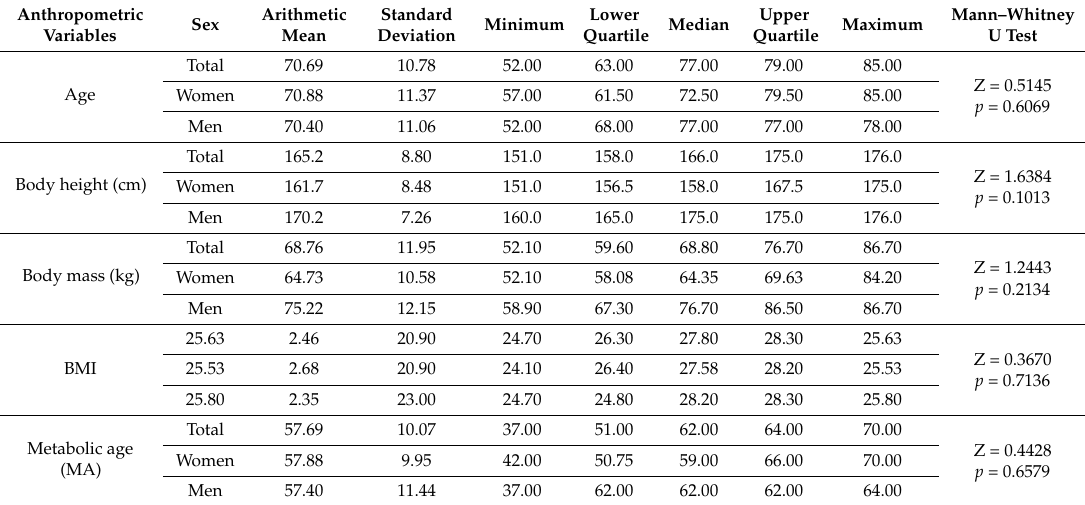
Table 1. Anthropometric